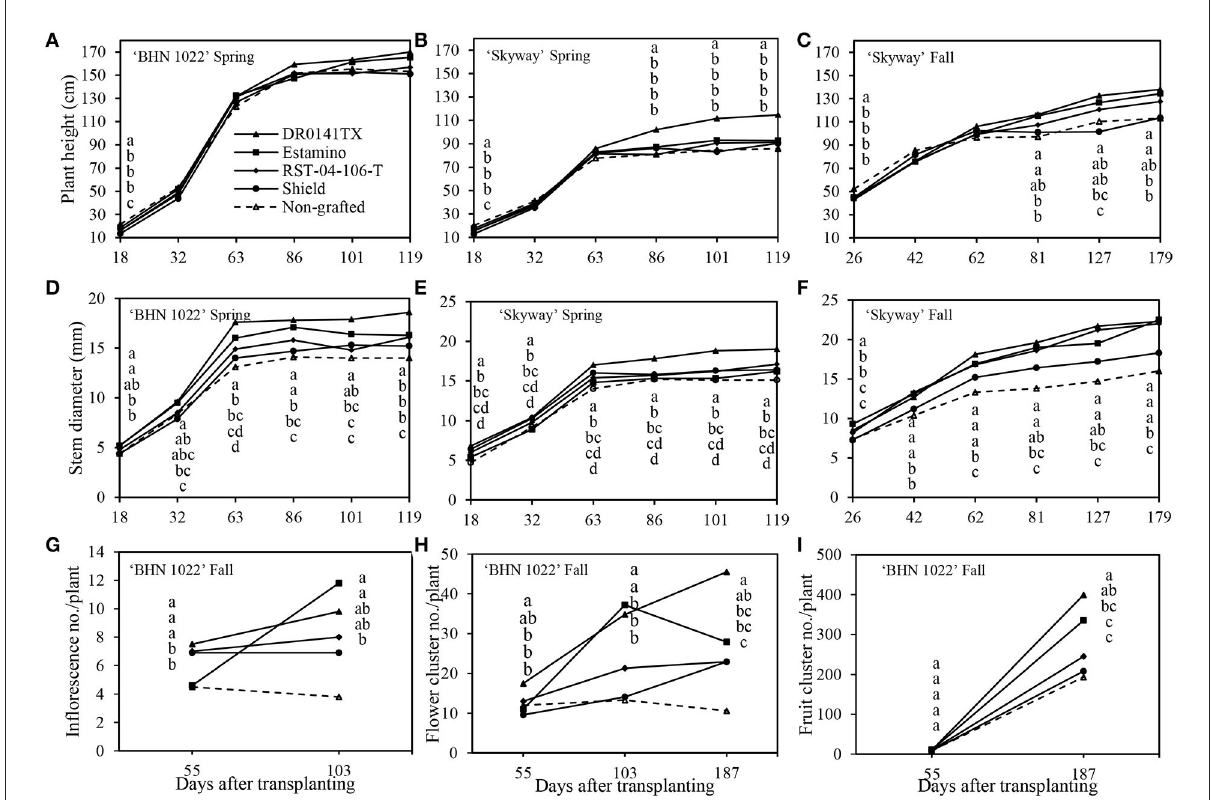
FIGURE2 Impacts of the four rootstocks on plant height, stem diameter, and floral features in the spring (14 February to 18 June 2020) and fall (24 September 2020 to 15 April 2021) plantings. Vegetative features are compared for the ‘BHN 1022’ grape tomato and ‘Skyway’ beefsteak tomato scions grafted onto different rootstocks. The inflorescence number, flower cluster number, and fruit cluster number were assessed for ‘BHN 1022’ grape tomato scion grafted with different rootstocks at 55 (before the 1st harvest of grape tomato), 103 (harvest week 6), and 187 DAT (at crop termination) in the fall planting. (A) Plant height of ‘BHN 1022’ in the spring planting. (B) Plant height of ‘Skyway’ in the spring planting. (C) Plant height of ‘Skyway’ in the fall planting. (D) Stem diameter of ‘BHN 1022’ in the spring planting. (E) Stem diameter of ‘Skyway’ in the spring planting. (F) Stem diameter of ‘Skyway’ in the fall planting. (G) Inflorescence number of ‘BHN 1022’ in the fall planting. (H) Flower cluster number of ‘BHN 1022’ in the fall planting. (I) Fruit cluster number of ‘BHN 1022’ in the fall planting. For the same measuring date, data with the same letter are not significantly different at P ≤ 0.05 according to Fisher’s LSD